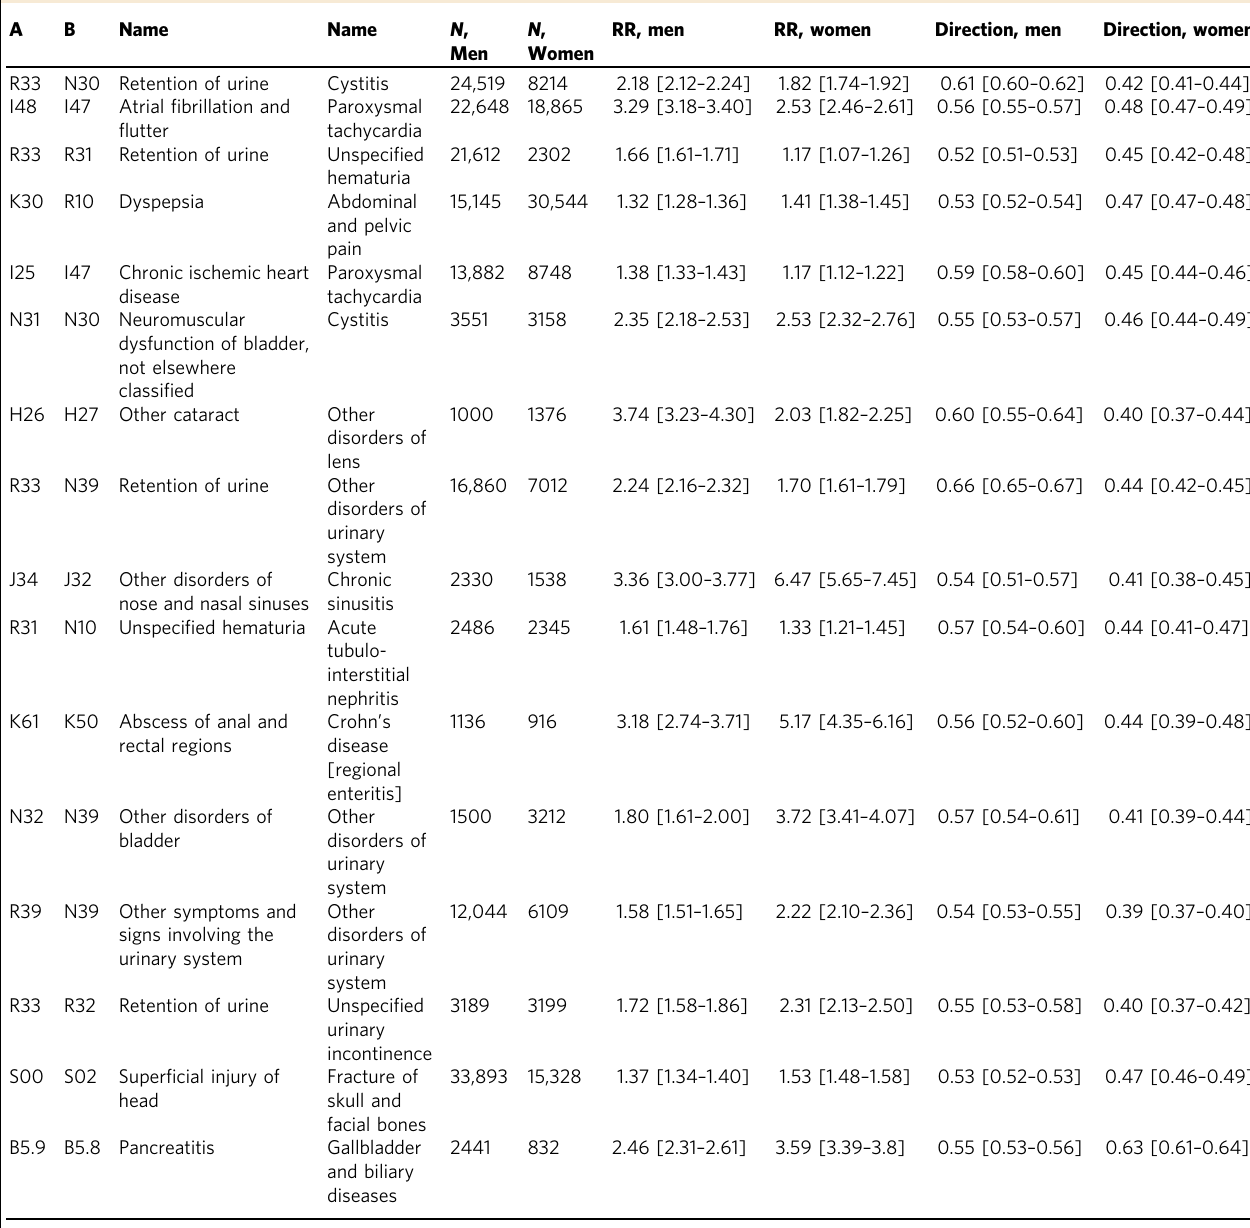
Table 1 Reversed directional comorbidities (including 95%